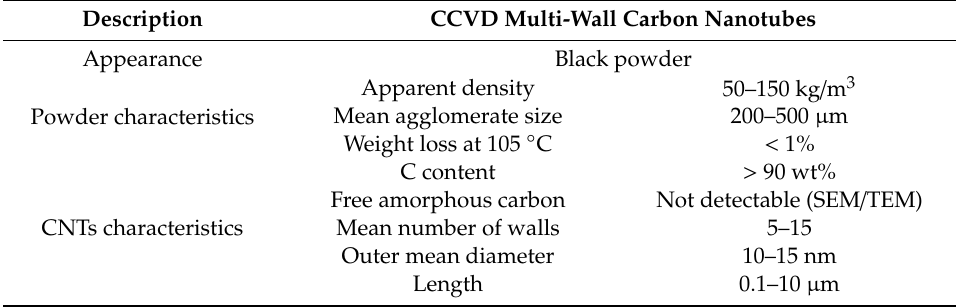
Table 1. Main properties of carbon nanotubes